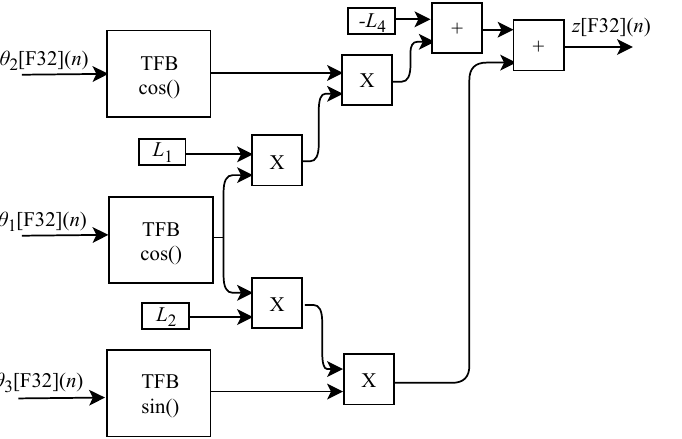
Figure 8. Proposed forward kinematics circuit for obtaining the z [ F 32 ]( n ) spatial coordinate (Equation (17))—FK-HMD and FK-HSD.